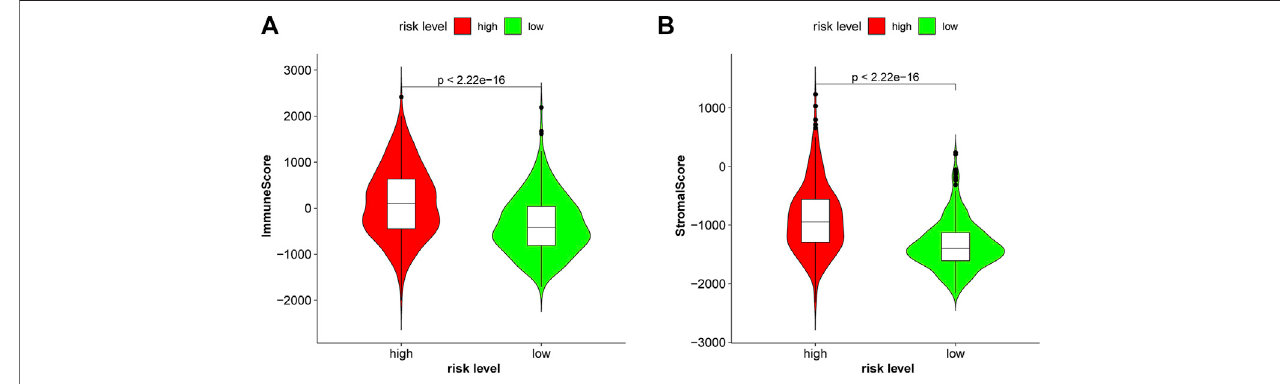
FIGURE 10 | Patients with glioma in the high-risk group had higher immune scores (A) and higher stromal scores (B) in the CGGA693.